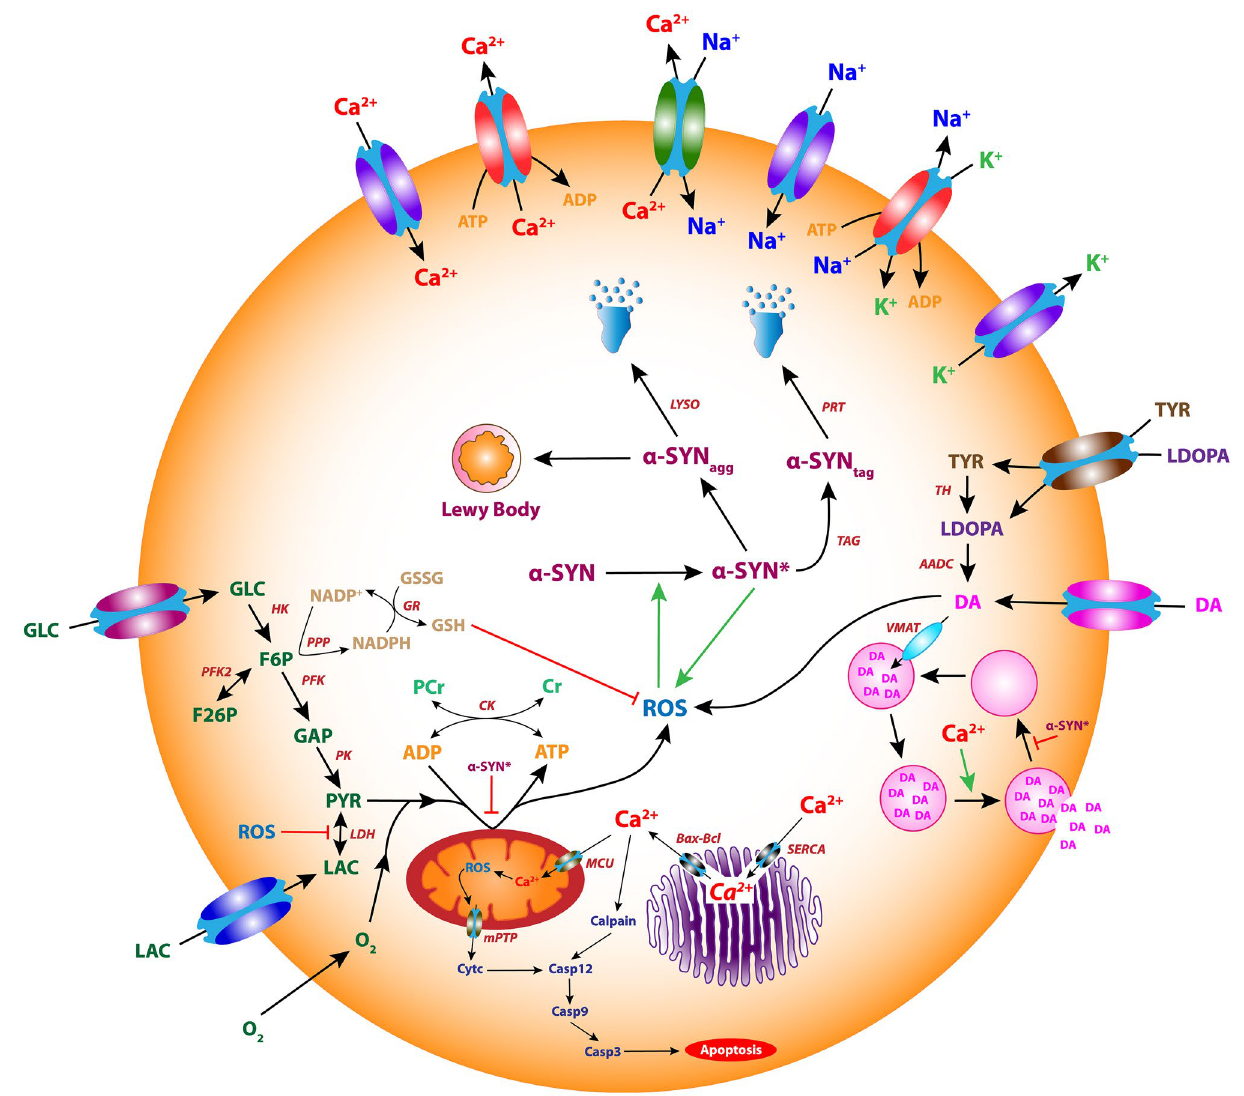
Figure 1. The proposed comprehensive model of the SNc